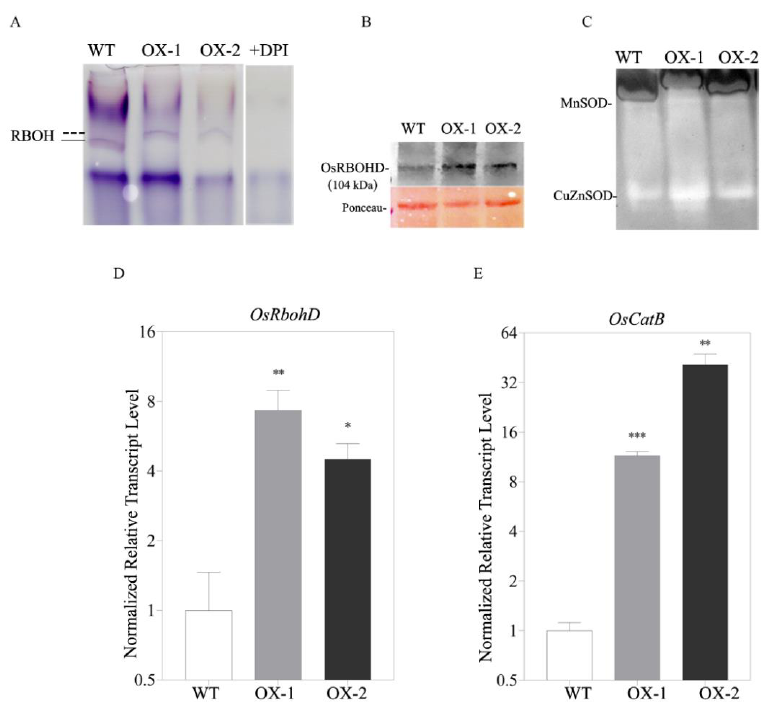
Figure 3. OsRACK1B alters the Rboh and antioxidant activity. ( A ) Native PAGE (in-gel) analysis of Rboh activity. Rice leaves from OsRACK1B overexpressed and WT plants were fractionated by de- naturing PAGE and assayed for Rboh activity. Fifty micromolar of Rboh inhibitor, DPI, was added to the microsomal fraction of leaf from wild-type rice plant before loading in the designated well of the native PAGE gel indicated in the Rboh activity gel. The straight and dotted lines in RBOH activ- ity gel indicate the different migration patterns of the Rboh enzyme. ( B ) Western blot analysis of OsRBOHD protein showing higher accumulation of the protein compared to the WT. An equal amount of leaf proteins extracted from the indicated genotypes was subjected to immunoblot